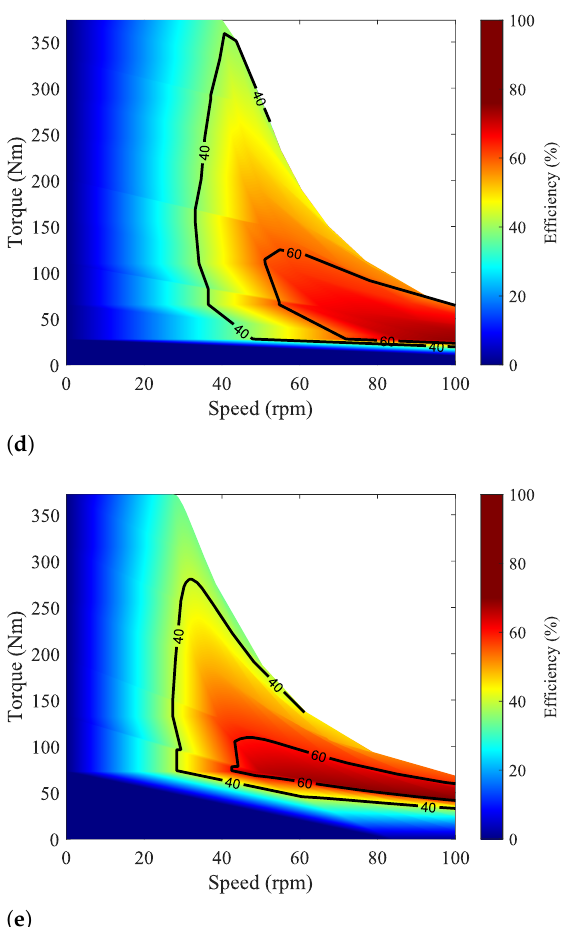
Figure 12. The efficiency according to speed. ( a ) Reference motor, ( b ) SPM motor, ( c ) Spoke motor, ( d ) SynREL motor, ( e ) PMaREL